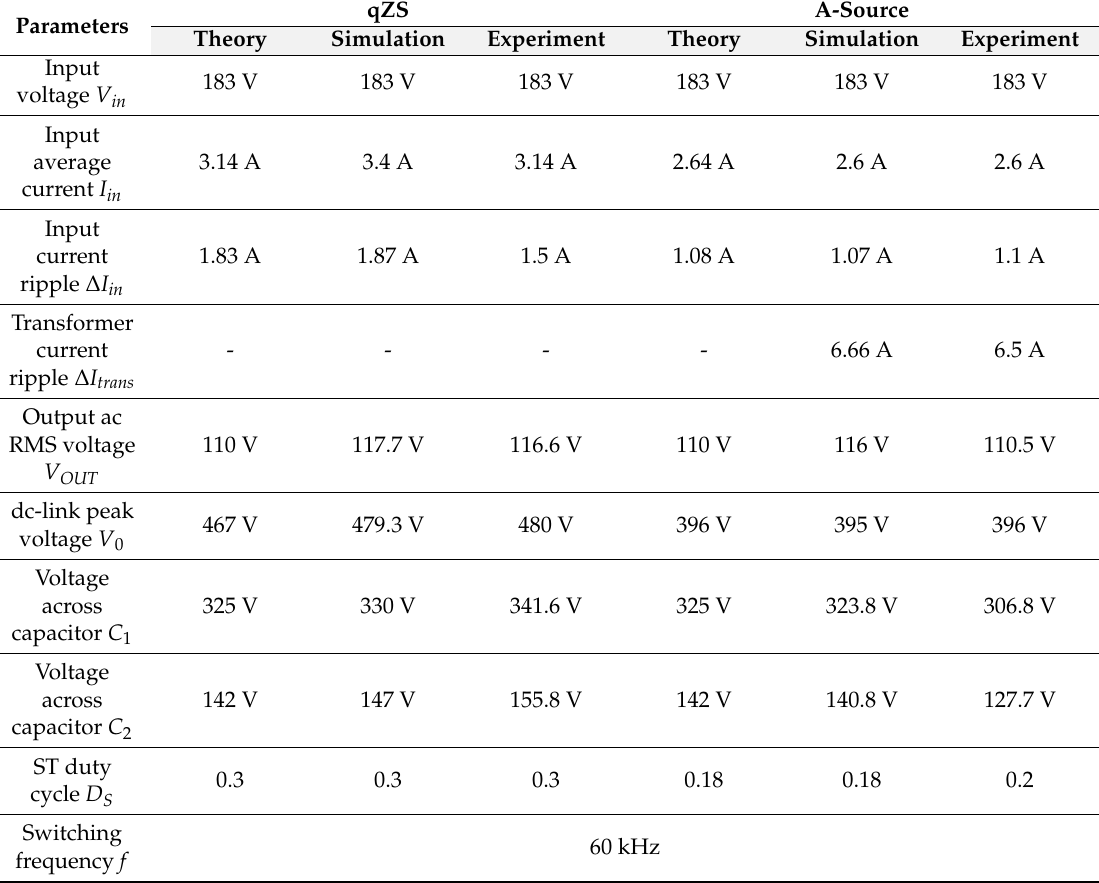
Table 2. Parameters of the Network Used for Simulation and Experimental